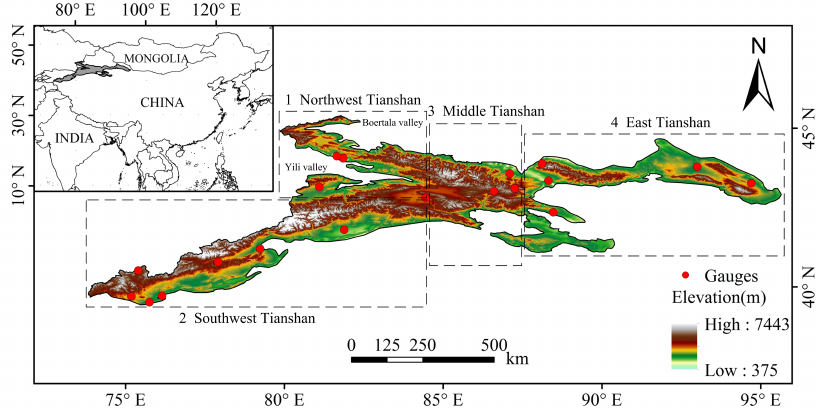
Figure 1. Location and topographic features of Tianshan Mountains and distribution of rain gauges. The black dashed line indicates the range of the four subregions: 1 Northwest Tianshan (TS1), 2 southwest Tianshan (TS2), 3 middle Tianshan (TS3), and 4 east Tianshan (TS4) (Base on map sources: GS (2020)